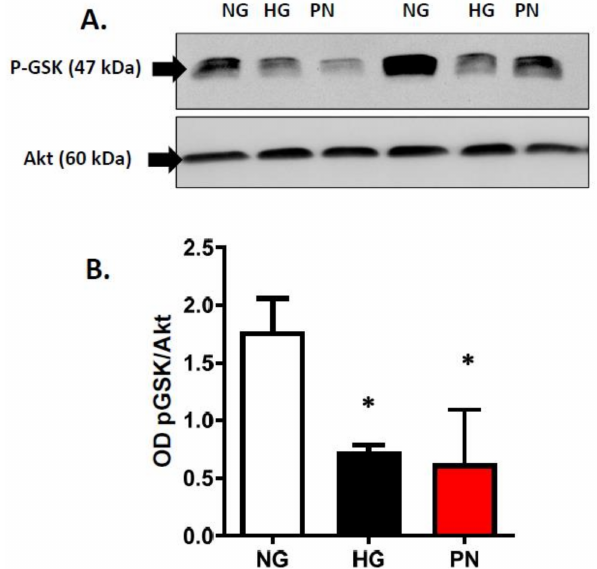
Figure 4. High glucose and peroxynitrite impaired Akt kinase activity. ( A ) Representative Western blot images of p-GSK-3 α / β (Ser21/9) associated with total Akt that were immune-precipitated from EC cultures treated with normal glucose (NG, 5 mM), high glucose (HG, 25 mM) for 3 days, or peroxynitrite (PN, 0.5 mM) for overnight. ( B ) Statistical analysis using one-way ANOVA showed that HG or PN significantly inhibited survival signal evident by significant decrease in GSK-3 α / β phosphorylation compared with NG. (* p < 0.05 versus NG, n = 3–4).